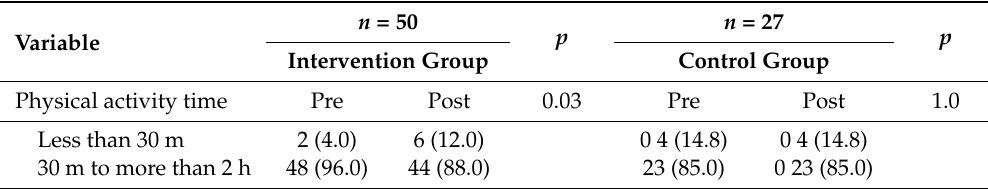
Table 2. Length of time (minutes or hours) of participating in physical activity.